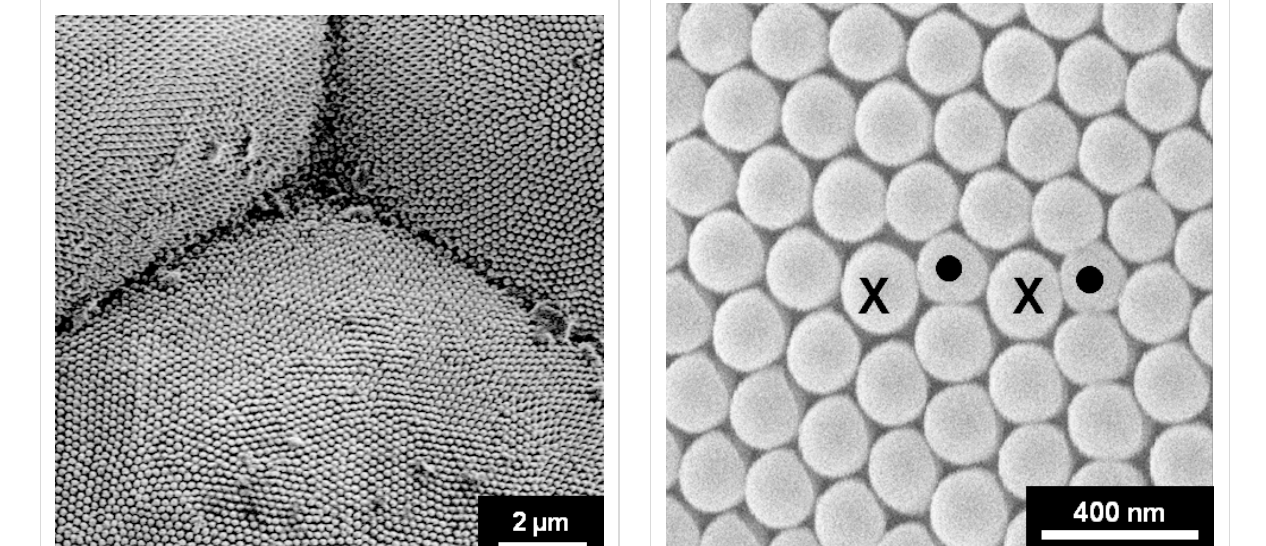
contamination-free areas of the eye were selected. Figure 3 shows a high magnification micrograph of the nipple arrange- ment in one of the highly ordered regions. While most of the nipples are arranged in a regular hexagonal close-packed pattern, the structure is defective at the points marked with “•” and “ X ”. We refer to these defects as 5–7 coordination defects, because the normal coordination number of six for the defect- free regions of the nipple arrangements is locally changed to five or seven nearest neighbors. It was observed that the nipples the average nipple diameter (150 nm) while the nipples with five nearest neighbors were slightly smaller. These coordina-